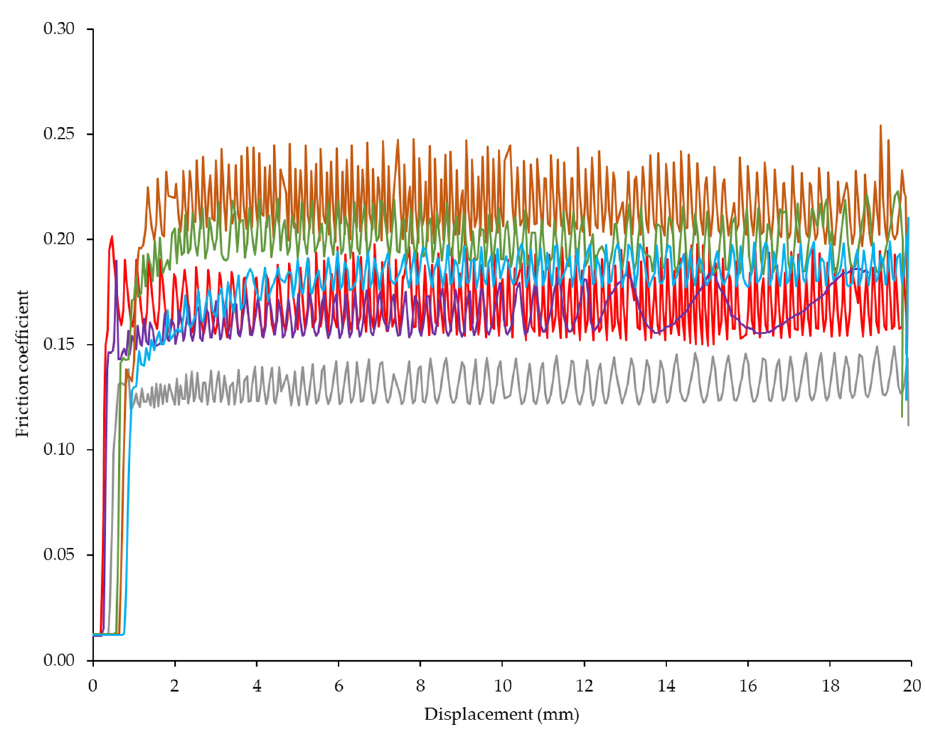
Figure 8. Representative examples of the variation of the coefficient of friction against the displace- ment for the different combinations of surfaces and sliding directions against steel: ▬ A-S; ▬ B-S; ▬ C-S; ▬ D-S; ▬ E-S; ▬ F-S.